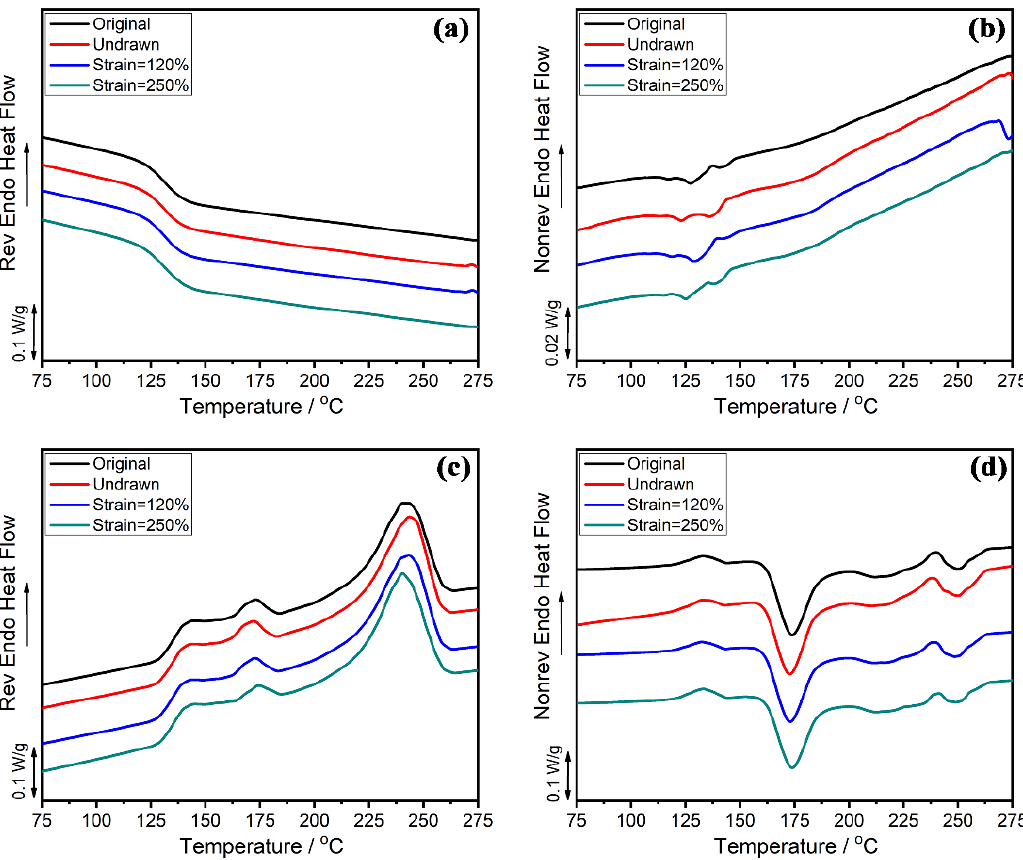
Figure 6. MDSC curves of PAPACM12 under different strain during cooling: ( a ) reversible signal, ( b ) nonreversible signal; second heating curves: ( c ) reversible signal, ( d ) nonreversible signal .